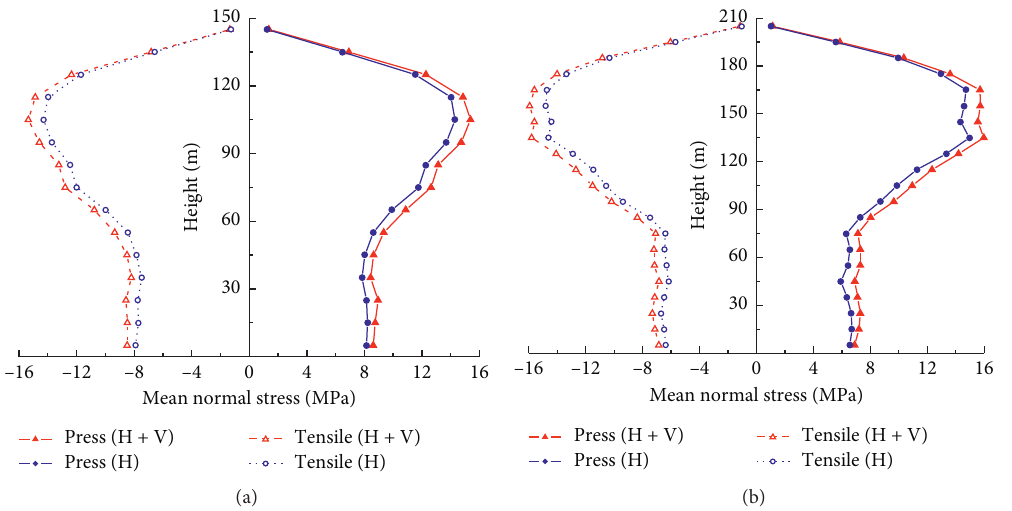
Figure 13: Comparison curve of the mean value of maximum earthquake normal stresses for chimneys under two types of seismic load: (a) 150m high chimney; (b) 210m high chimney. Table 13: Maximum earthquake compressive stresses of the 150m high chimney when only horizontal seismic acceleration is inputted. Serial number High